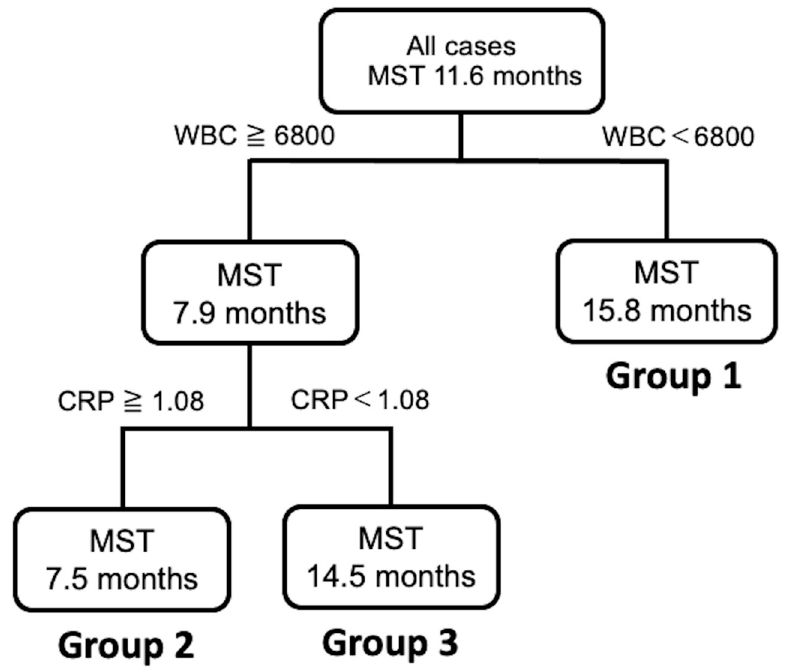
Figure 4. Decision tree analysis for the prognosis of patients with unresectable ICC.